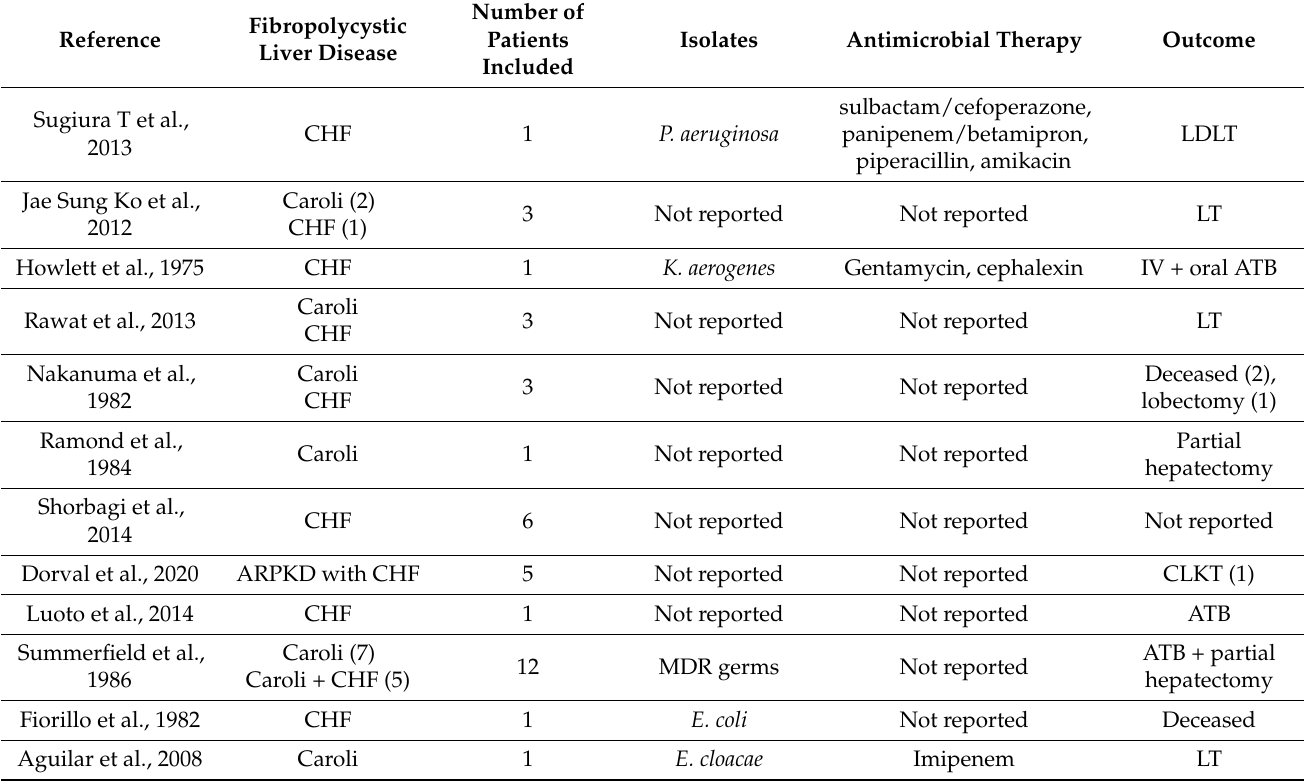
Table 1. Cases of recurrent cholangitis due to fibropolycistic liver disease reported in the literature. Number of Fibropolycystic Isolates Reference